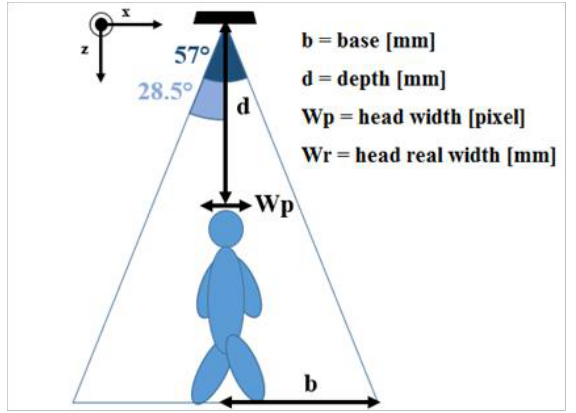
Figure 5. Side view of the system